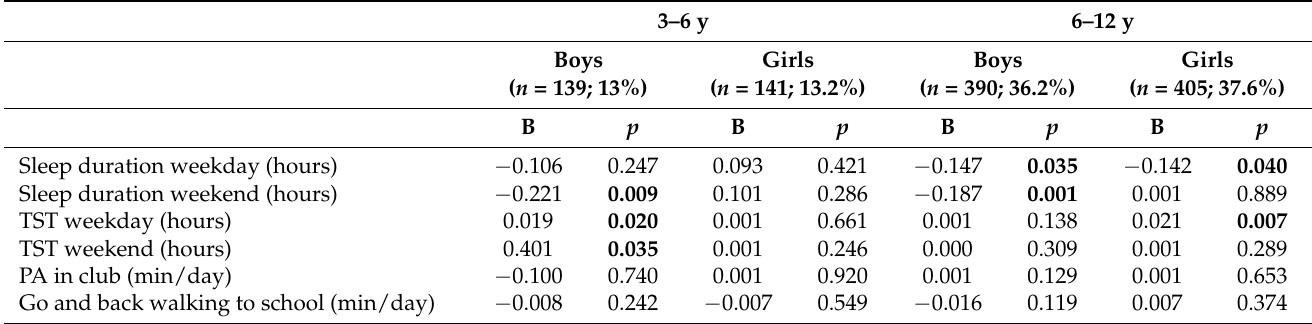
Table 4. Association between total screen time categories and BMI z-score ( n = 1075).